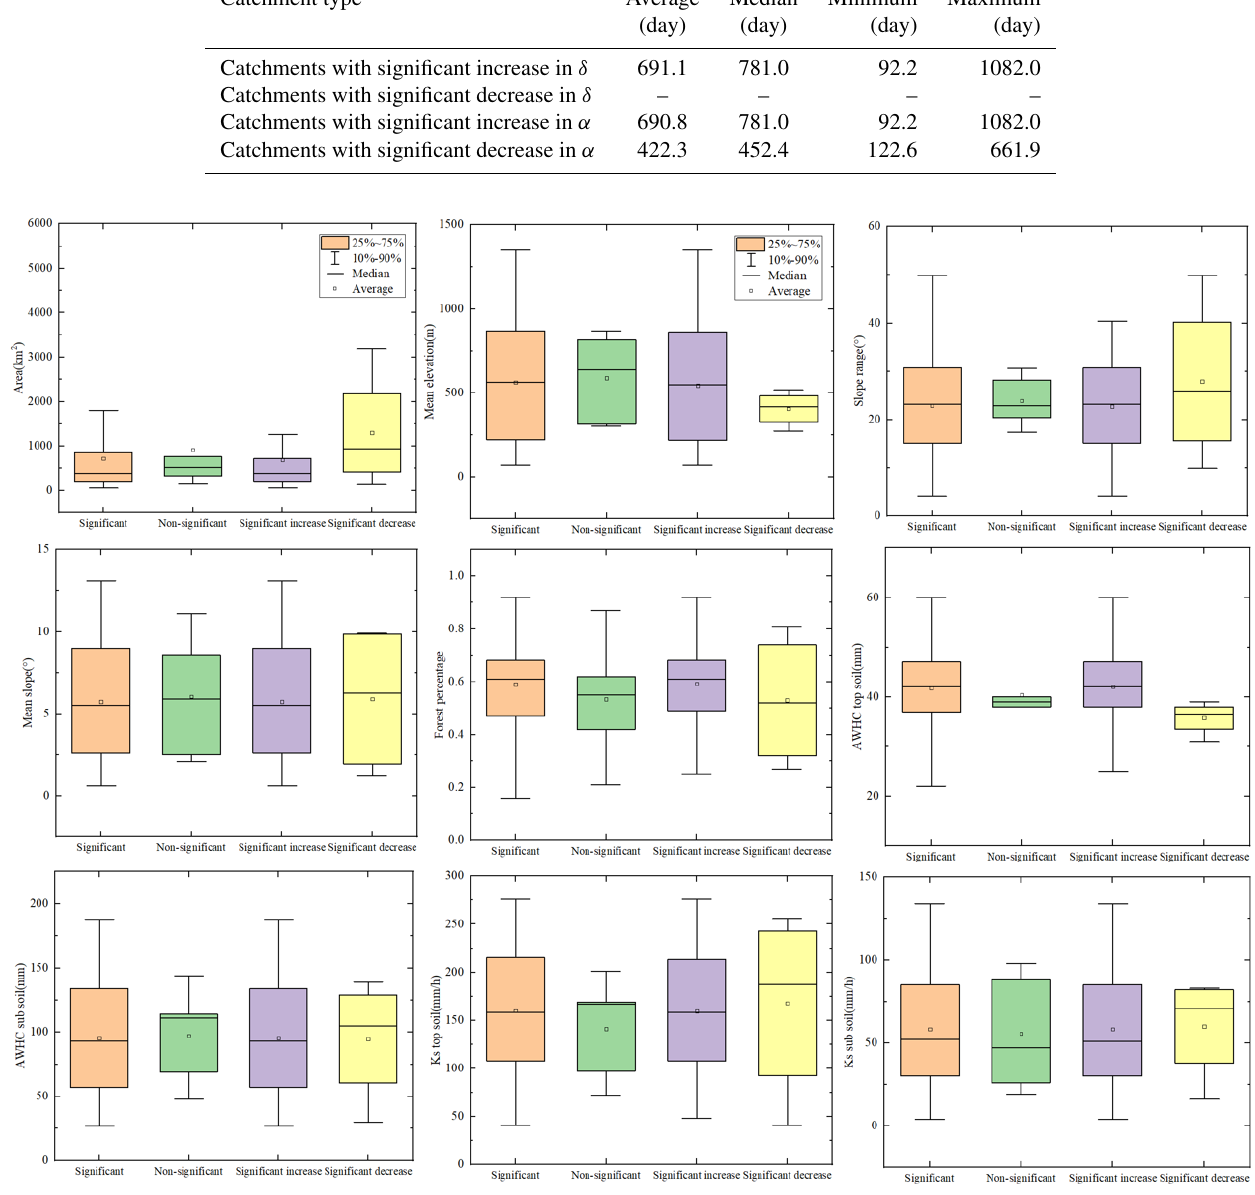
Figure 9. Comparison of physical features between the g α ( S ) and g α ( NS ) groups and g α ( SI ) and g α ( SD ) subsets for the study catchments. The orange and green boxes (two left columns) denote the physical characteristics of the g α ( S ) and g α ( NS ) groups which were divided according to the significance level of the variation in the amplitude after the change point. The purple and yellow columns (two right columns) denote the catchment features of the g α ( SI ) and g α ( SD ) subsets with significantly increased and decreased change patterns in the amplitude after the change point,